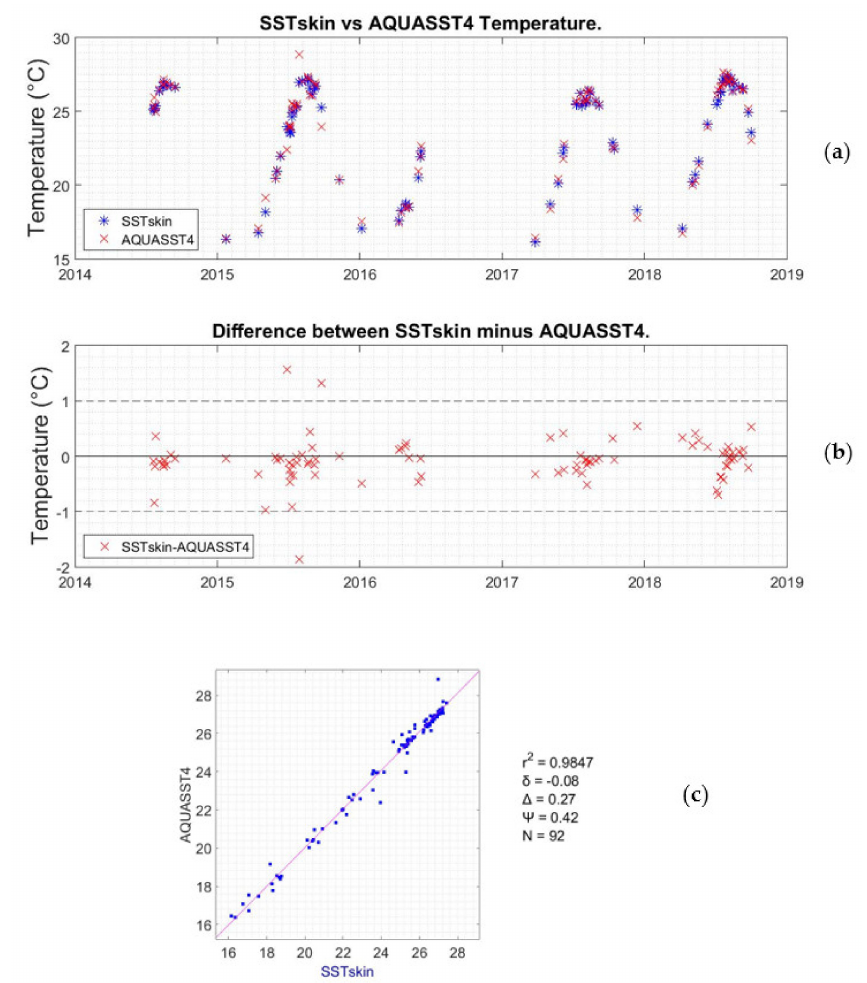
Figure 6. ( a ) SSTskin extracted and averaged data within ± 1 h of the respective satellite overpass compared with Aqua Moderate Resolution Imaging Spectroradiometer (MODIS) data from the swath’s cell that contains the Seafloor Observatory from the AQUASST4 dataset. ( b ) Di ff erence between the SSTskin minus the AQUASST4 dataset. ( c ) Correlation plot between the SSTskin and the AQUASST4 dataset (refer to Section 2.4 for